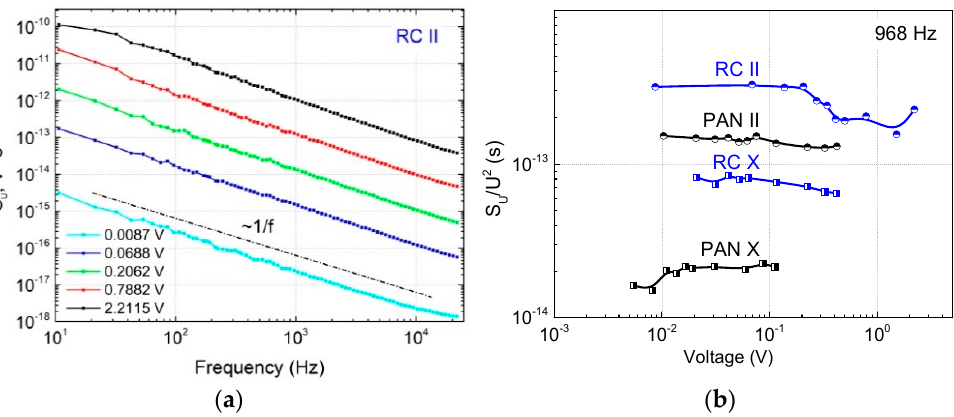
Figure 3. Voltage noise spectra for the RC II composite at different voltages ( a ) and voltage noise spectral density versus voltage dependencies for different samples ( b ) at room temperature.